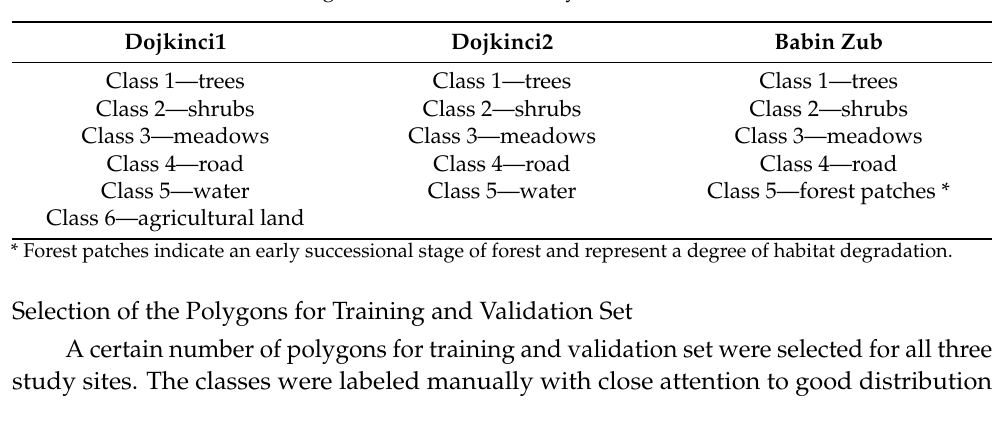
Table 2. Land cover classes are given in each of the study